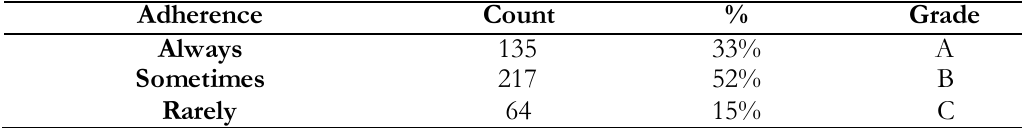
Table: 2 Patient adherences to medications in Aseer region Adherence